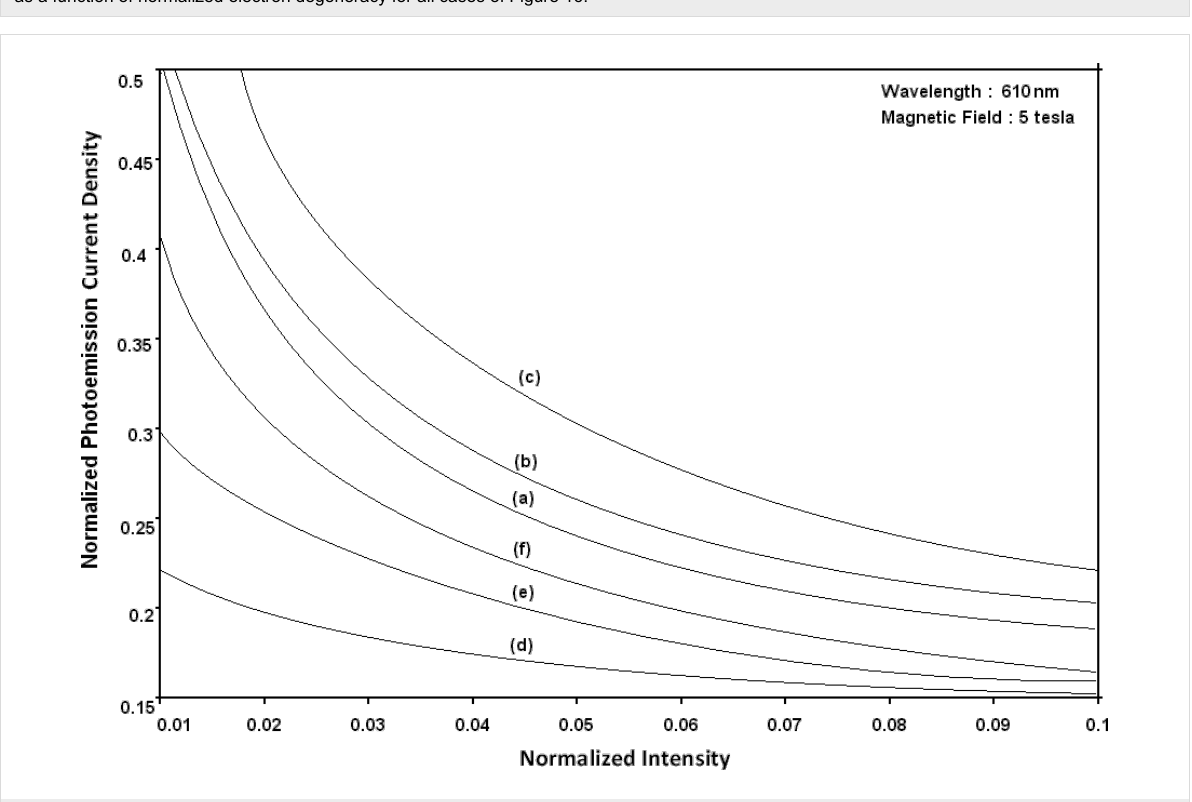
Figure 17: Plot of the normalized magneto photoemission current density from effective mass superlattices of HgTe/Hg 1 − x Cd x Te and In x Ga 1 − x As/InP as a function of normalized electron degeneracy for all cases of Figure 16.